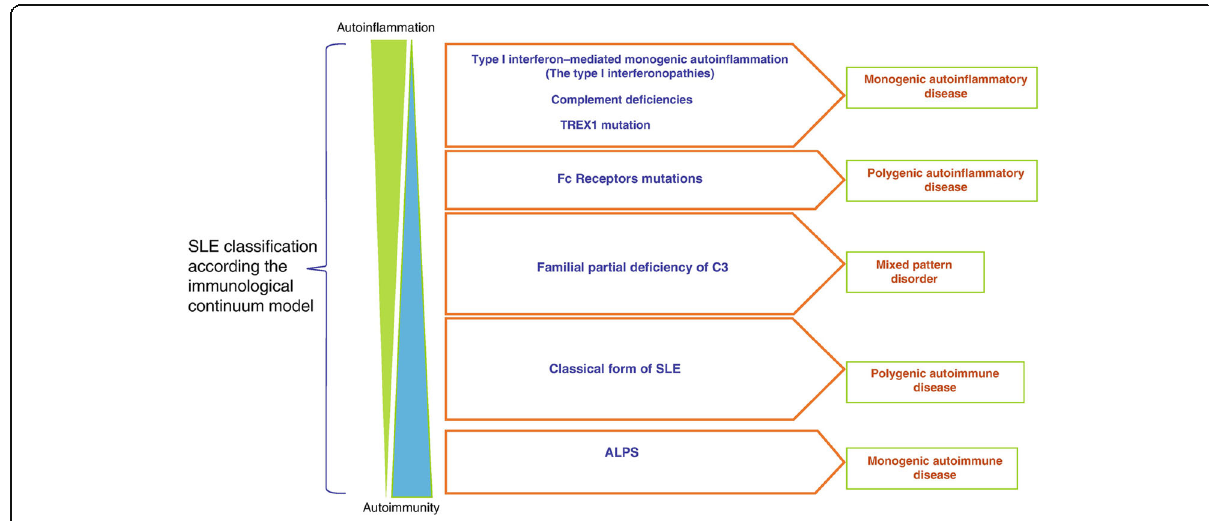
Fig. 2 SLE is a one of the best examples in which the immunological continuum model can be applied showing the diversity of clinical manifestation according the involvement of different genetic and immune system components. SLE systemic lupus erythematosus;